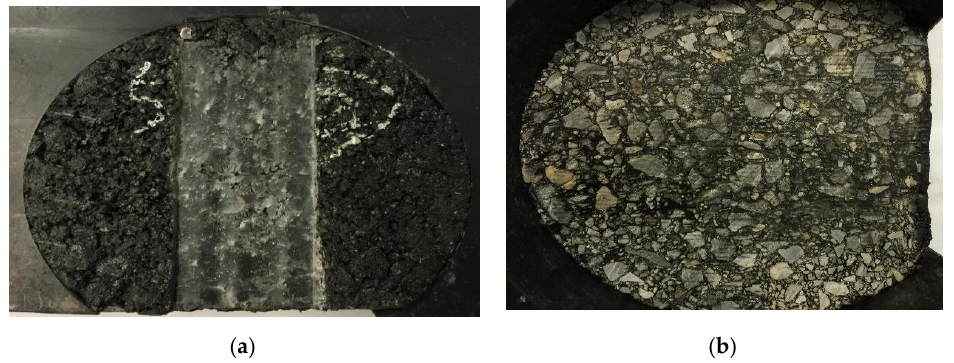
Figure 9. Specimen #4 (1-inch thickness, 10 days aging, without a notch), ( a ) specimen top and ( b ) specimen bottom.